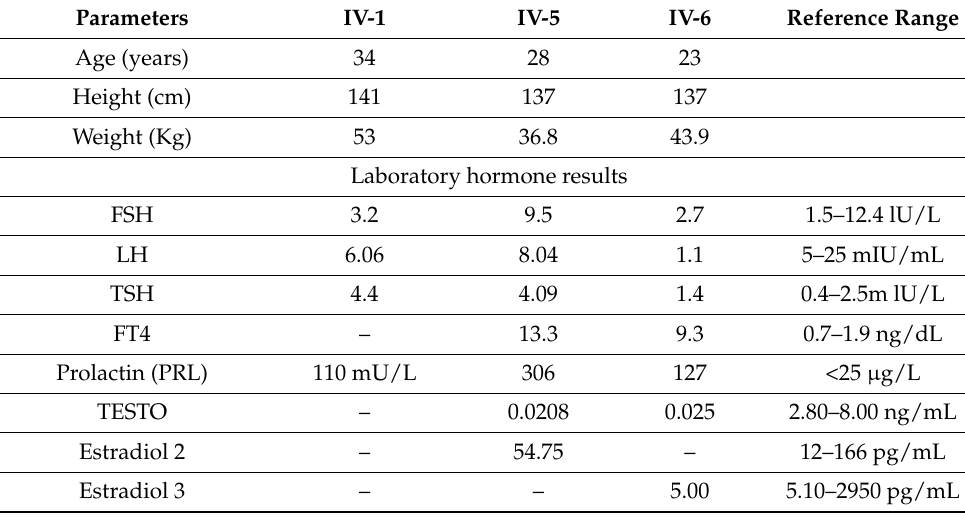
Table 1. Common clinical and hormonal findings of affected